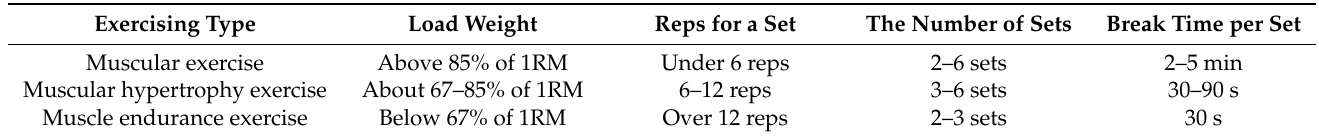
Table 7. The load weight, the number of reps for a set, the number of sets and break time depending on the exercising type